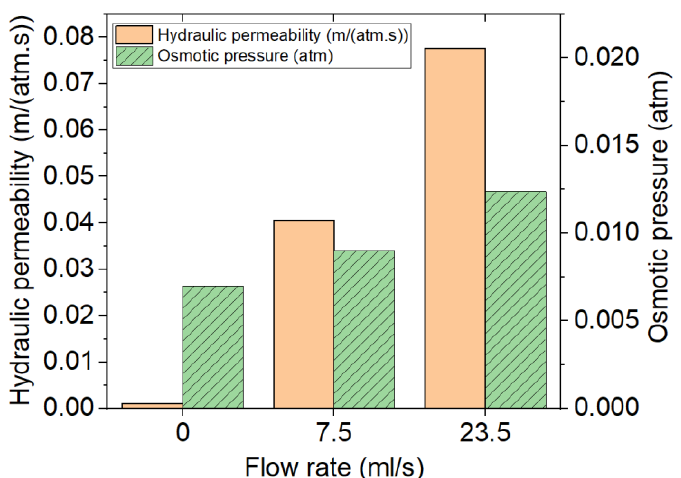
Figure 10. Comparison of the values of permeability and osmotic pressure for samples of PU-20% DE at three different flow rates of 0, 7.5 and 23.5 mL/s